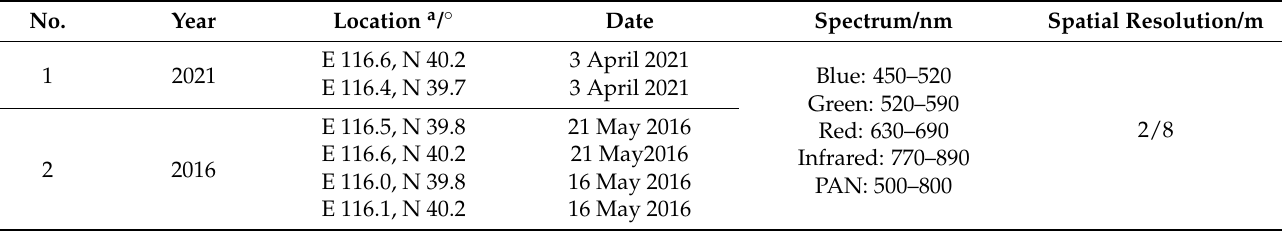
Figure 1. The study area comprises ( a ) the BUA of Beijing in 2016 and 2021; ( b ) the BUA of Beijing in 2016; and ( c ) the BUA of Beijing in 2021. GaoFen-1 shows the true color composite of the blue, green, and red bands of the original image data. Table 1. GF-1 data applied in this study.